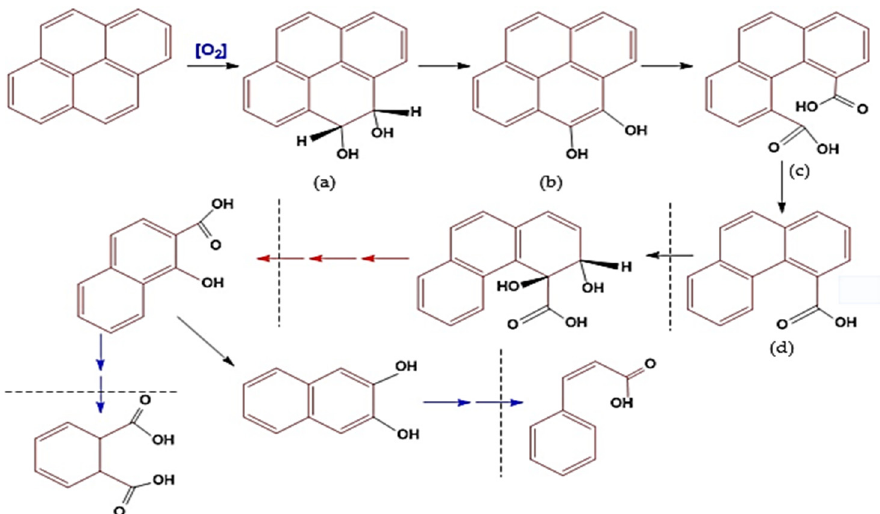
Figure 5. Illustration of the mechanism of biodegradation of pyrene components using Bacillus sp. bacteria, through the following metabolic reactions: ( a ) Pyrene molecules undergo oxidation; ( b ) a keto-enol molecule is formed; ( c ) One benzene ring is broken to form a carboxylic acid compound; (d) a simple carboxylate molecule separates to form penanthroic acid. The next degradation process is through an oxidation reaction which leaves benzoate compounds. Figure has been modified based on some references [99,110,113,116].